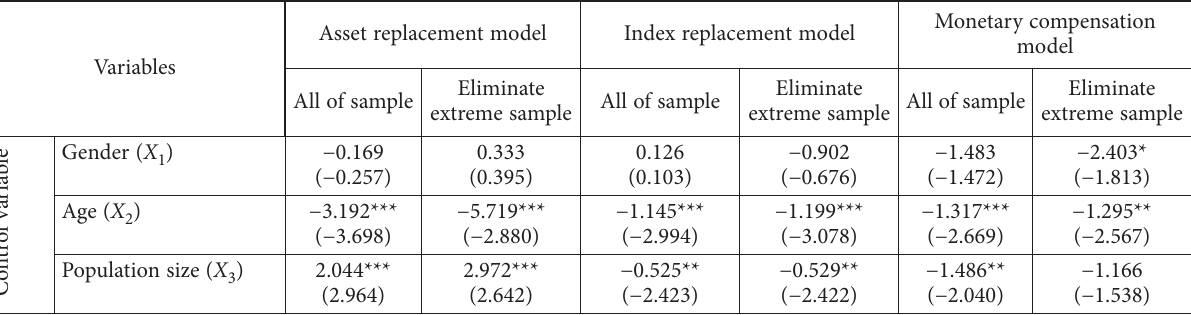
Table 6. Results of individual